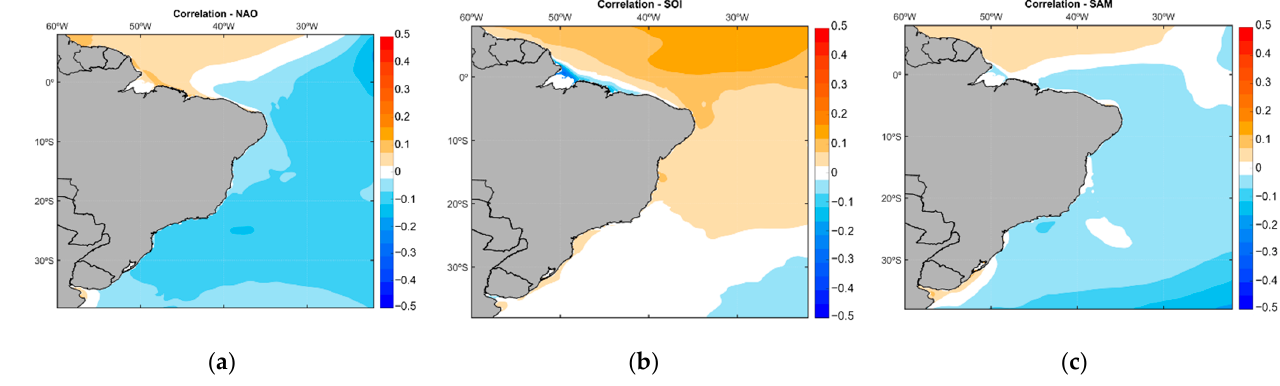
Figure 9. Spatial correlations (dimensionless) of 𝐻 (cid:3046) with NAO ( a ), SOI ( b ), and SAM ( c ).